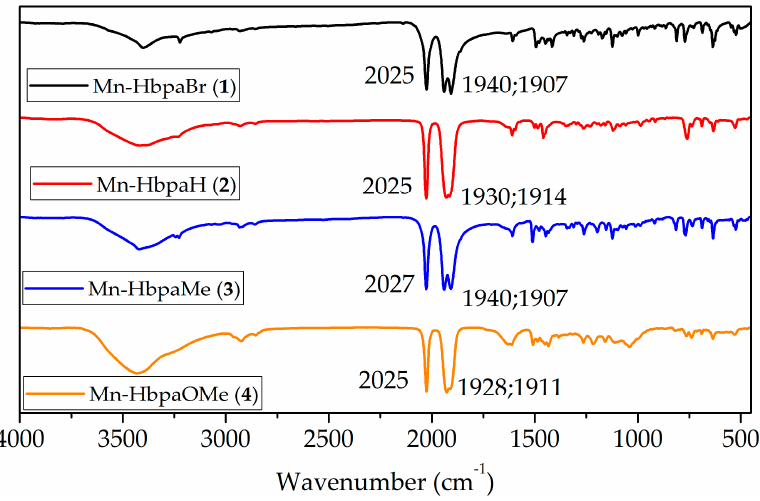
Figure 3. IR spectra of compounds ( 1 )–( 4 ) at 4.0 cm − 1 resolution (FTIR, KBr pellets).